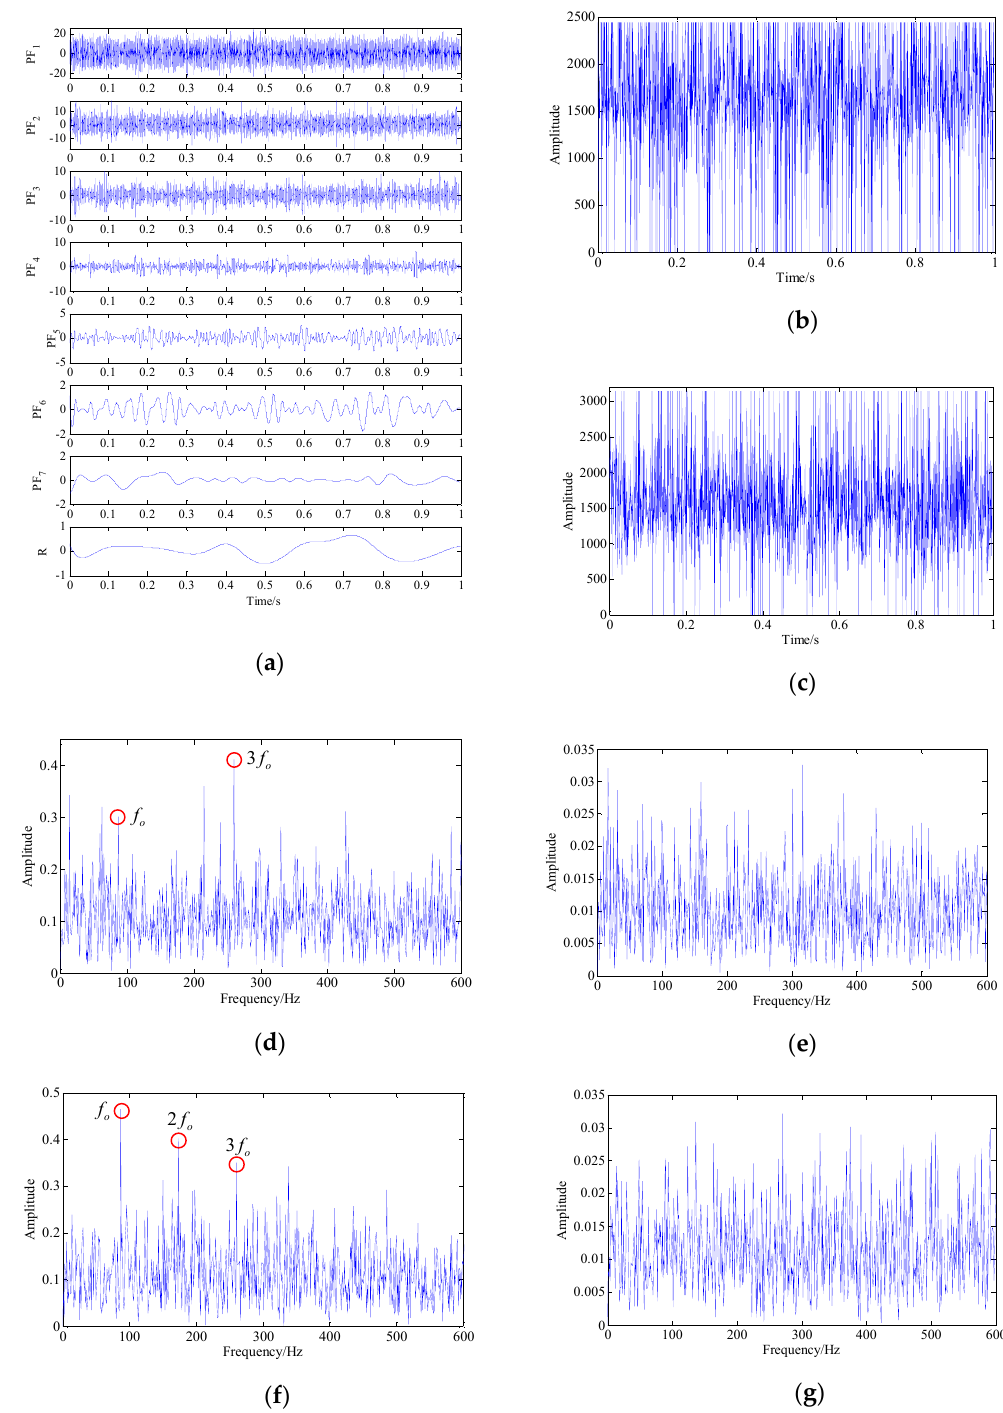
Figure 13. Analysis results of the demodulation analysis technique based on local mean decomposition (LMD) and energy separation: ( a ) waveform of the PFs and residuals; ( b , c ) instantaneous frequency waveforms of PF1 and PF2; ( d , f ) envelope spectra of PF1 and PF2; ( e , g ) instantaneous frequency spectra of PF1 and PF2 .